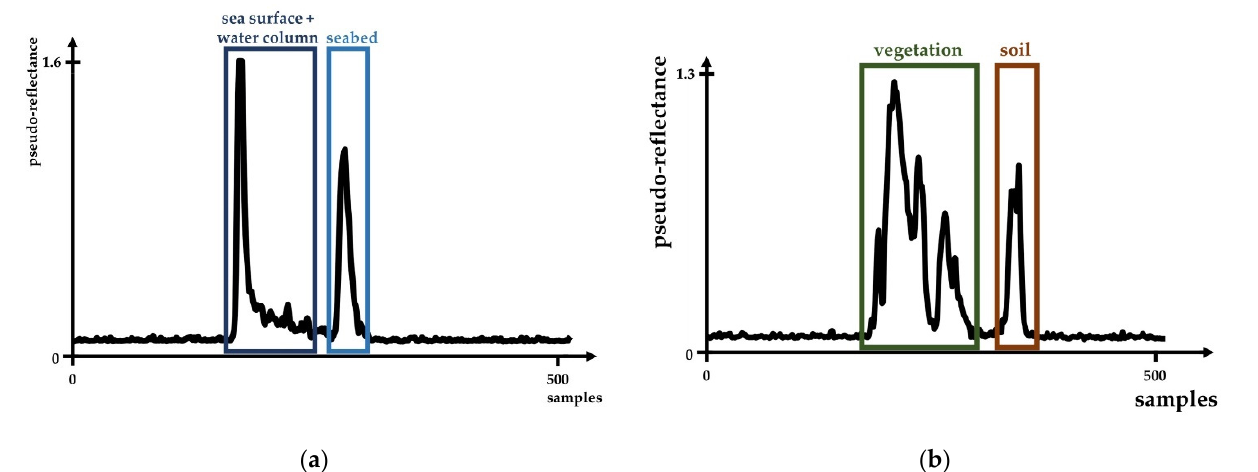
Figure 2. Examples of typical lidar waveforms (for a green laser with a wavelength of 515 nm). ( a ) Bathymetric waveform acquired in a coastal area; ( b ) topographic waveform acquired in a vegetated area. A sample corresponds to 556 picoseconds.